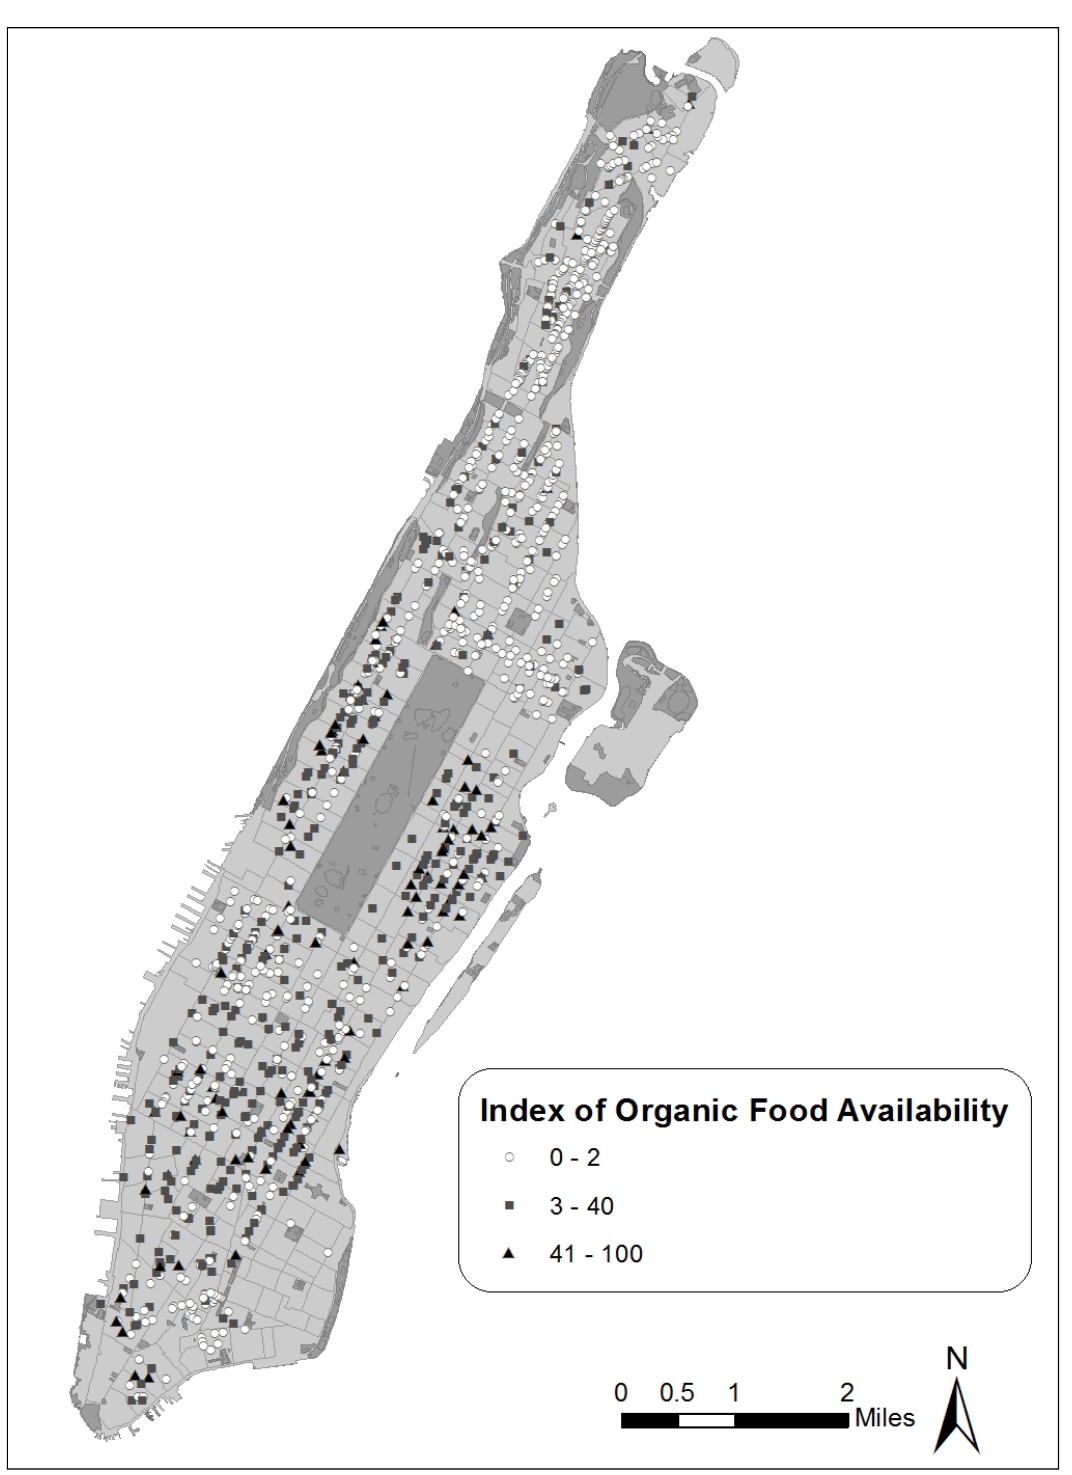
Figure 1. Organic Food Availability in Manhattan, New York, January